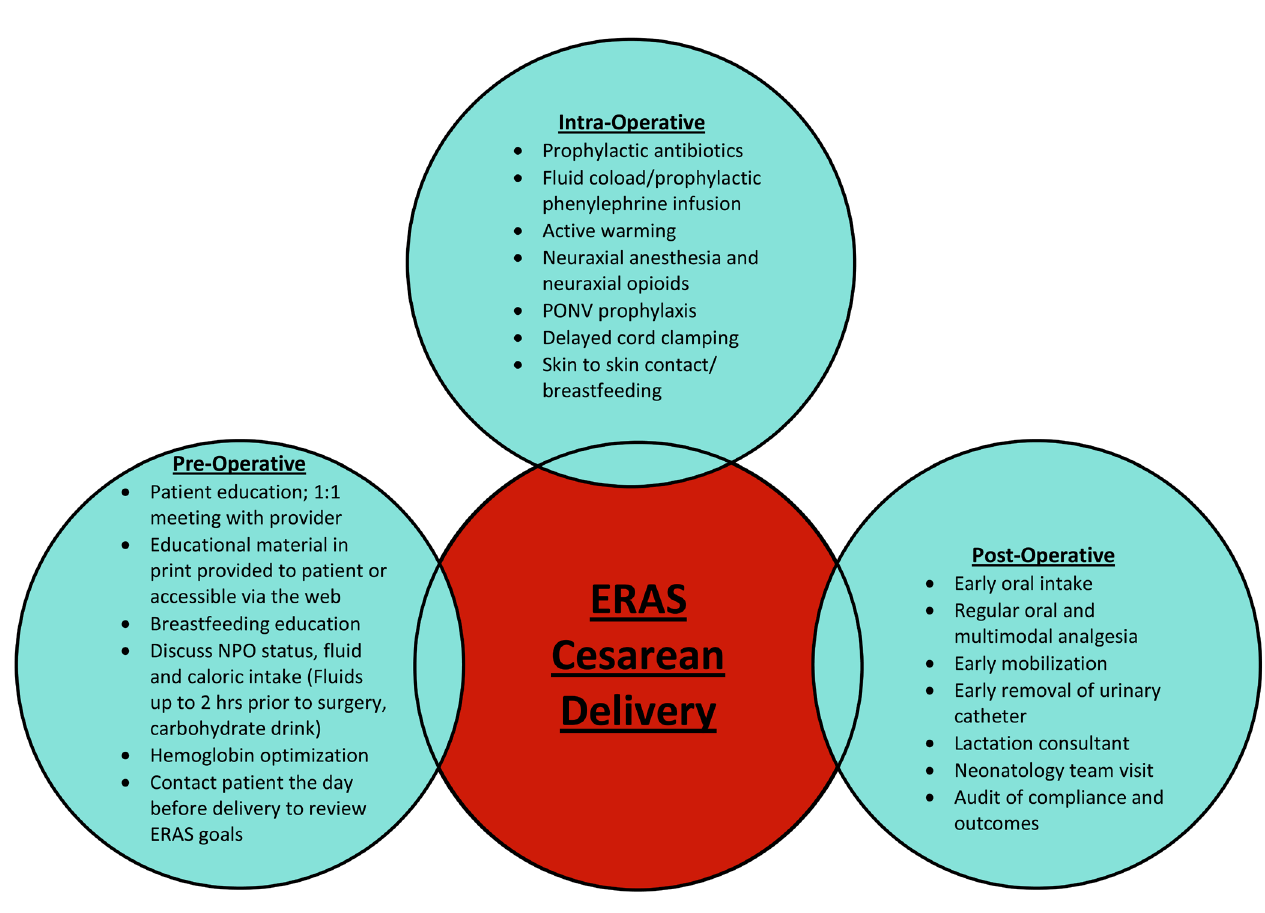
Figure 1. Components of Enhanced Recovery Protocol for Cesarean Delivery. ERAS, enhanced recovery after surgery; NPO, nil per os (nothing by mouth); PONV, postoperative nausea and vomiting.